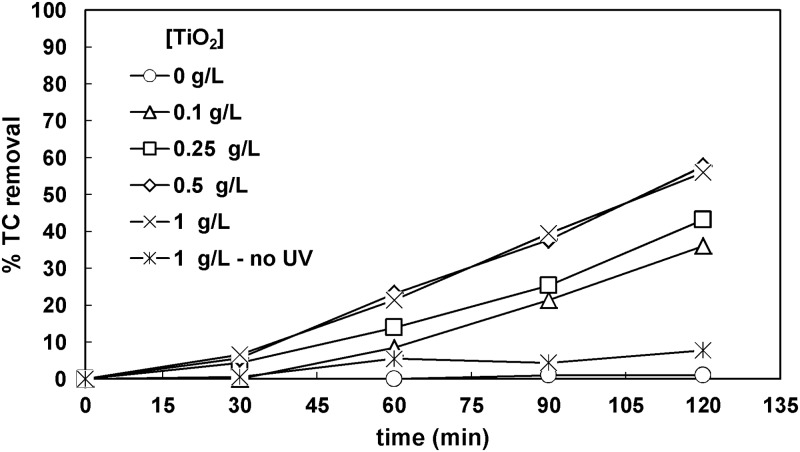
Effect of TiO2 loading on TC removal ([TC]o = 32 mg L-1).